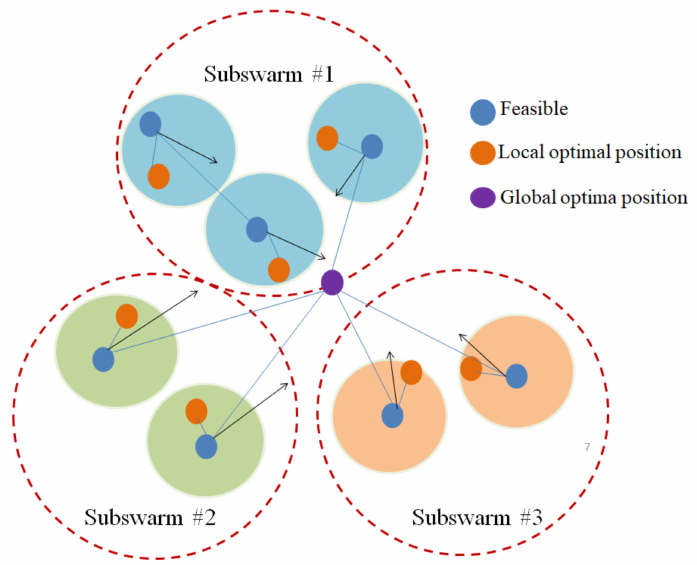
Figure 3. Dynamic behaviour of the particle movement for three multiswarms in multiswarm PSO (MSPSO)